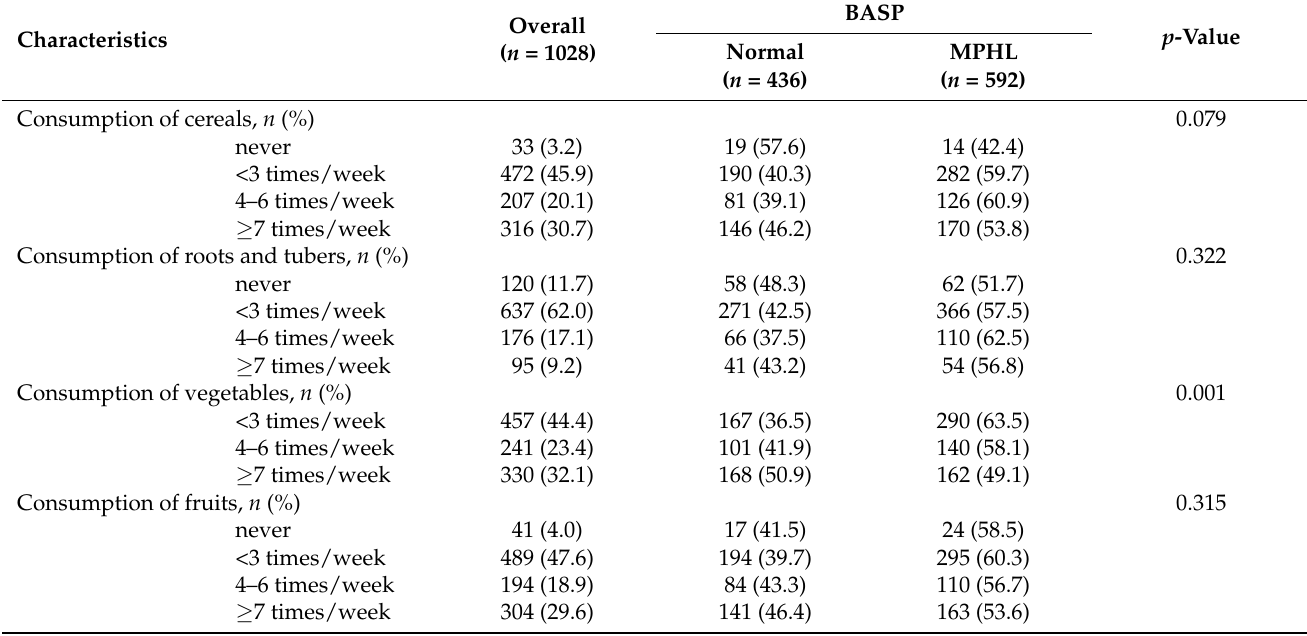
Table 2. Differences of dietary intake frequencies in past month among participants with and without male pattern hair loss